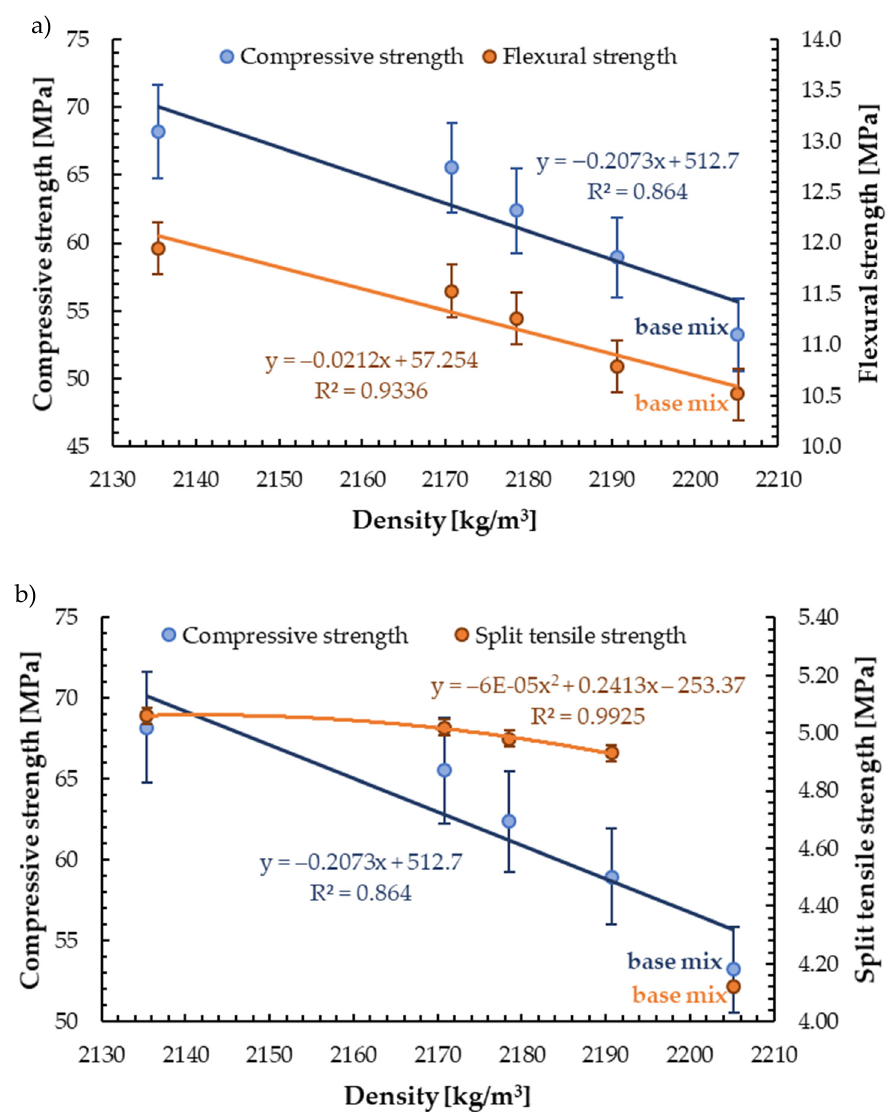
Figure 10. Effect of density on the mechanical properties of mortar containing glass sand aggregate, ( a ) relationship between density and compressive/flexural strength, ( b ) relationship between density and compressive/split tensile strength.